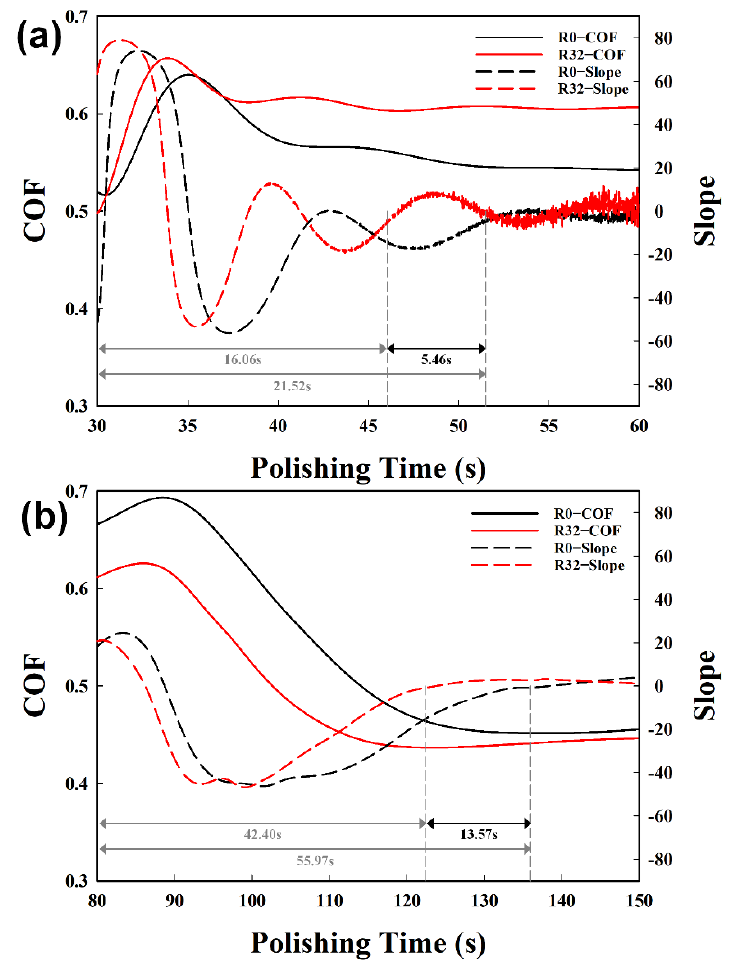
Figure 12. The measured COF, relevant slope, and slurry saturation time in the ( a ) coupon wafer polished by the 100 mm wafer polisher, and ( b ) 300 mm wafer polished by the 300 mm wafer polisher with R0 pads and R32 pads.